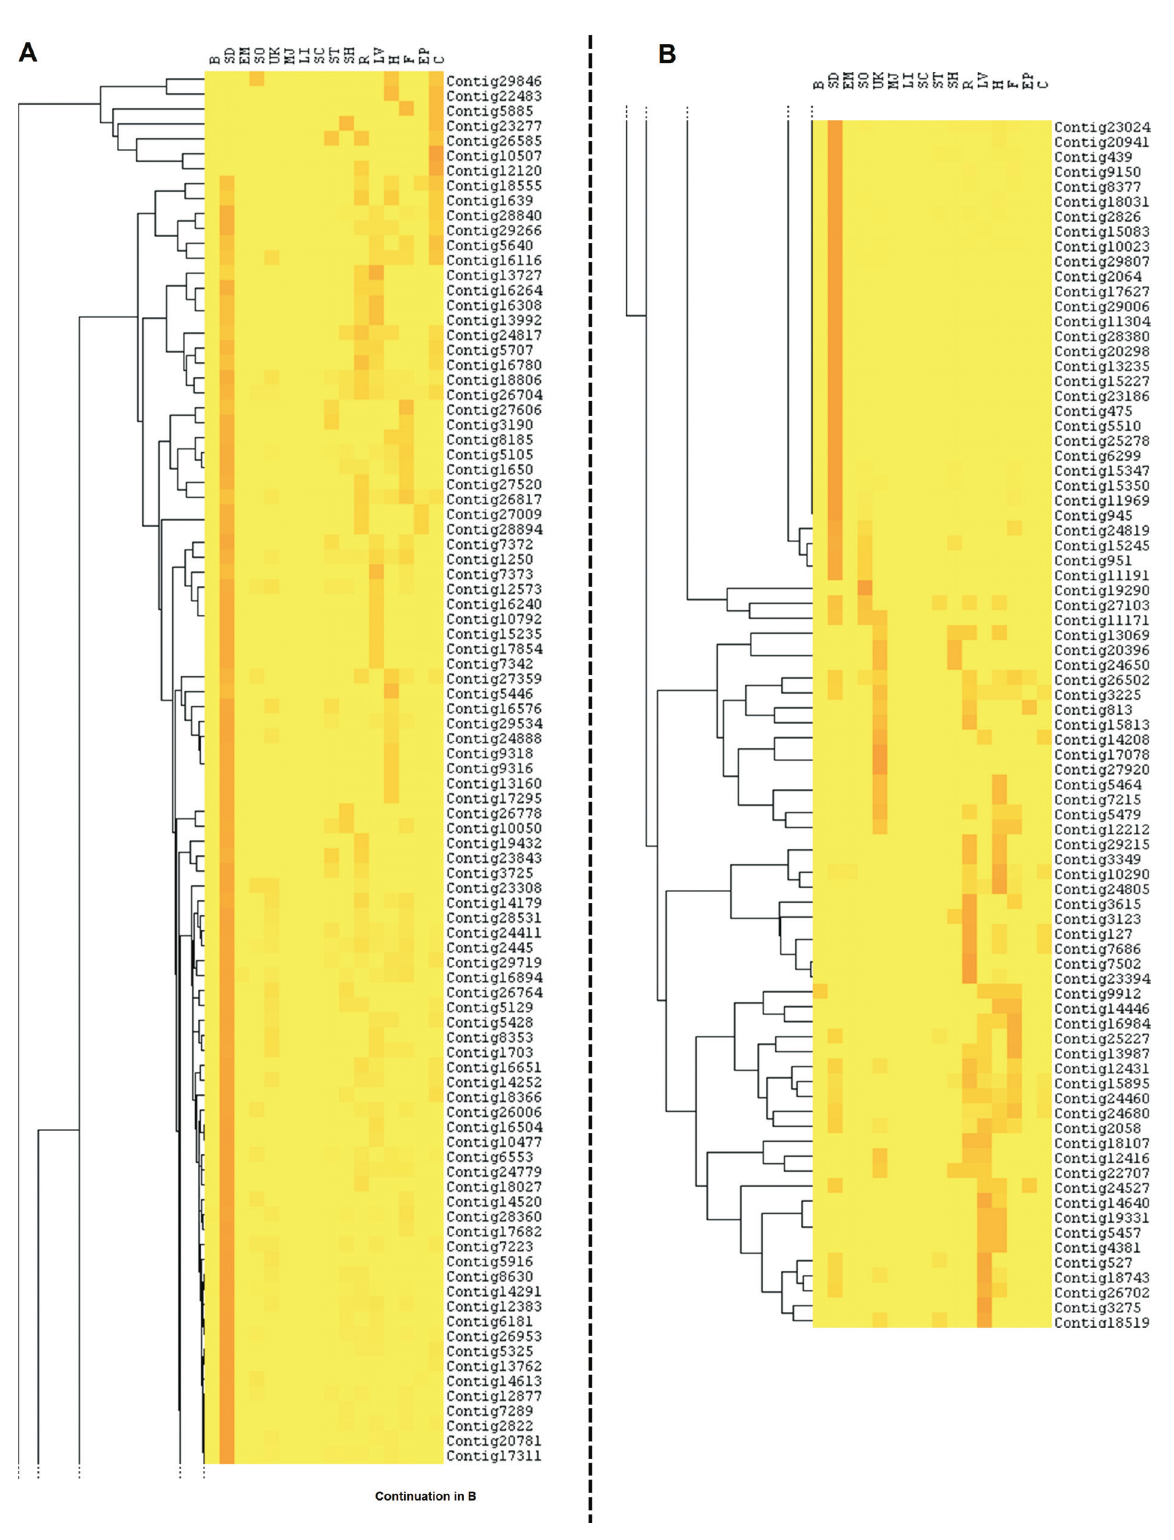
Figure S1 - Xa21 expression profile in 16 different libraries from